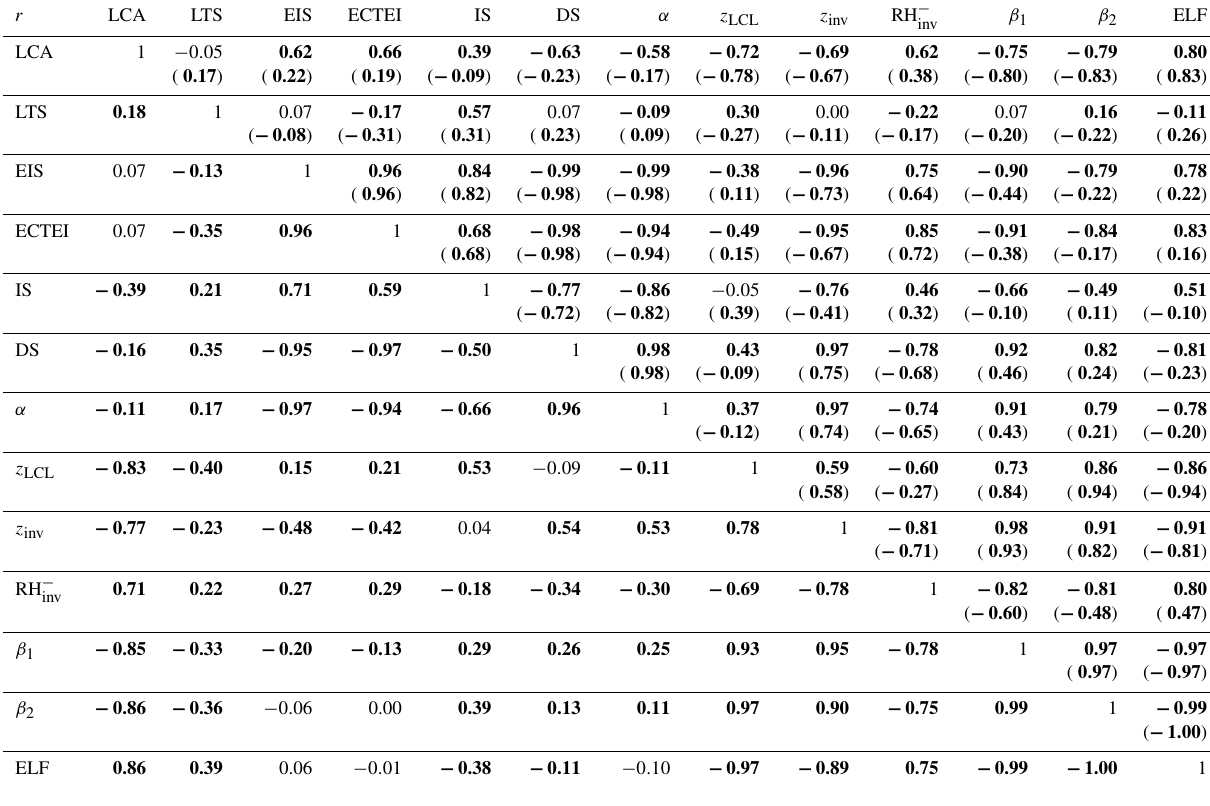
Table 1. Spatial–seasonal correlation coefficients between LCA and various proxies for the climatological seasonal data (DJF, MAM, JJA, SON) of each 5 ◦ latitude × 10 ◦ longitude grid box (values in the upper right: over the ocean; values in the lower left: over land; and values within the parenthesis: over the entire globe including the coast). Statistically significant correlations at the 99.9% confidence level from the Student t test assuming independent samples are denoted by the bold characters. The same convention is applied to the following tables. Only the data satisfying 0 < α < 1 are used for this